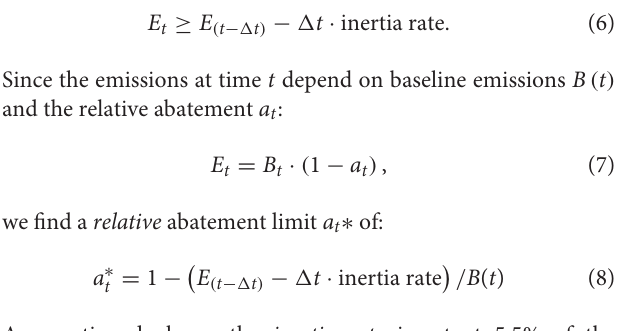
IPCC Special Report on Global Warming of 1.5 ◦ C (https:// data.ene.iiasa.ac.at/iamc-1.5c-explorer), we assumed that